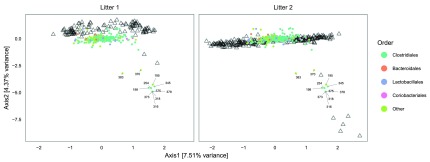
The analogue to
Figure 17, faceting by litter membership rather than age bin.